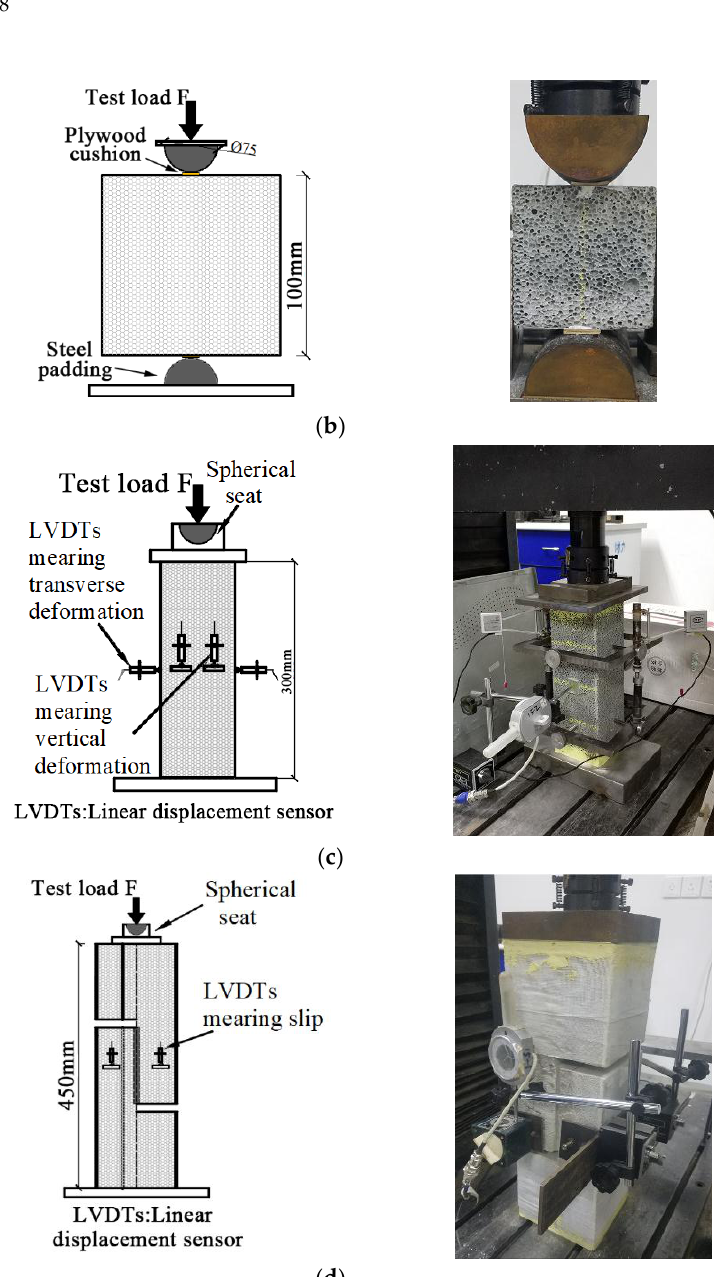
Figure 4. Test setups. ( a ) Four-point flexural tests; ( b ) Splitting tensile strength test; ( c ) Uniaxial compression test; ( d ) Shear Test.